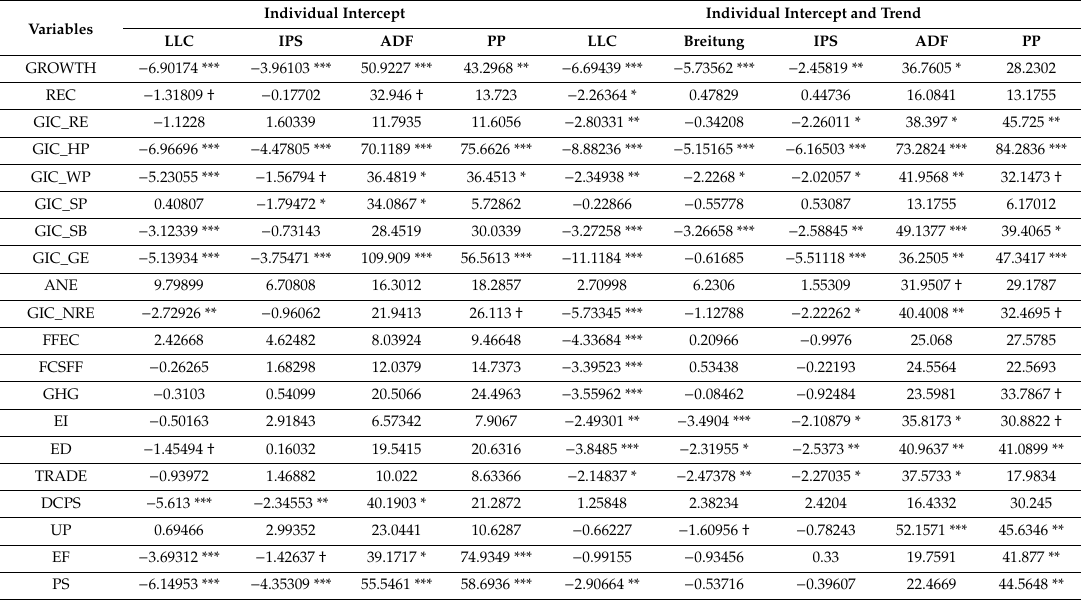
Table 9. Results of the panel unit-root: variables at level.